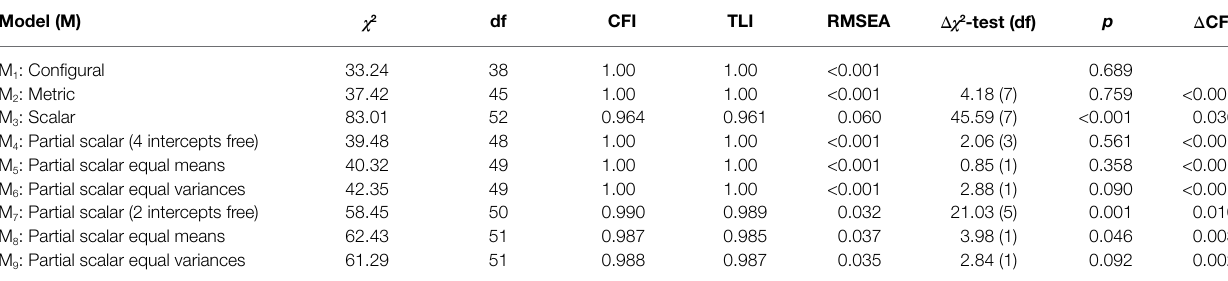
TABLE 6 | Fit indices of Closeness and Conflict: factor structure models. Sample χ 2 df Whole sample ( N =